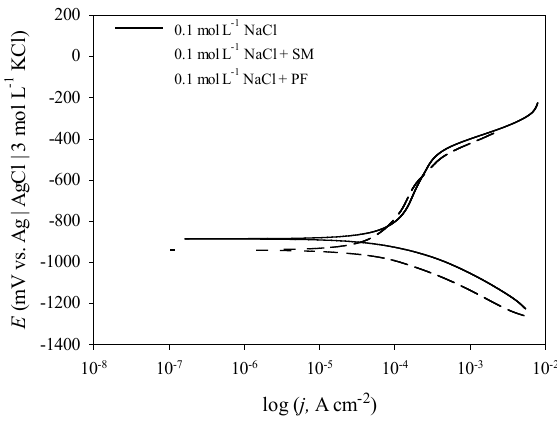
Figure 1: Potentiodynamic polarization curves for Fe electrode in 0.1 mol L-1 NaCl containing SM extract and phenolic fraction (PF) of Satureja montana L. n = 1 mV s −1 .